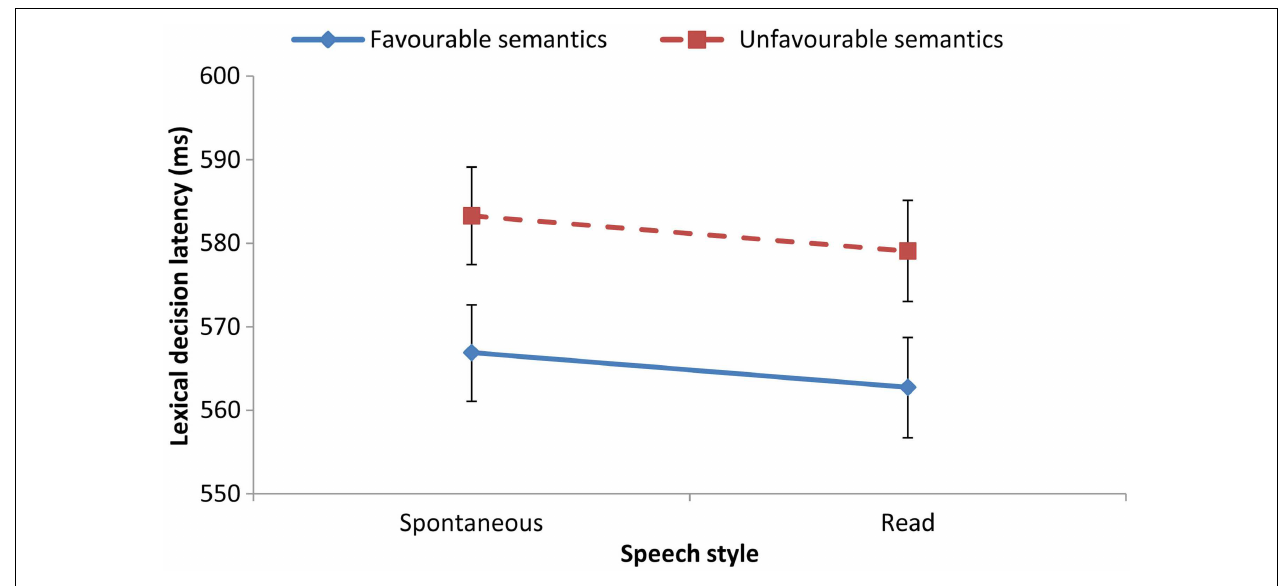
FIGURE 2 | Lexical-decision latencies (and standard errors) in the semantic segmentation condition for the two speech styles: spontaneous map dialogs vs. read sentences (101